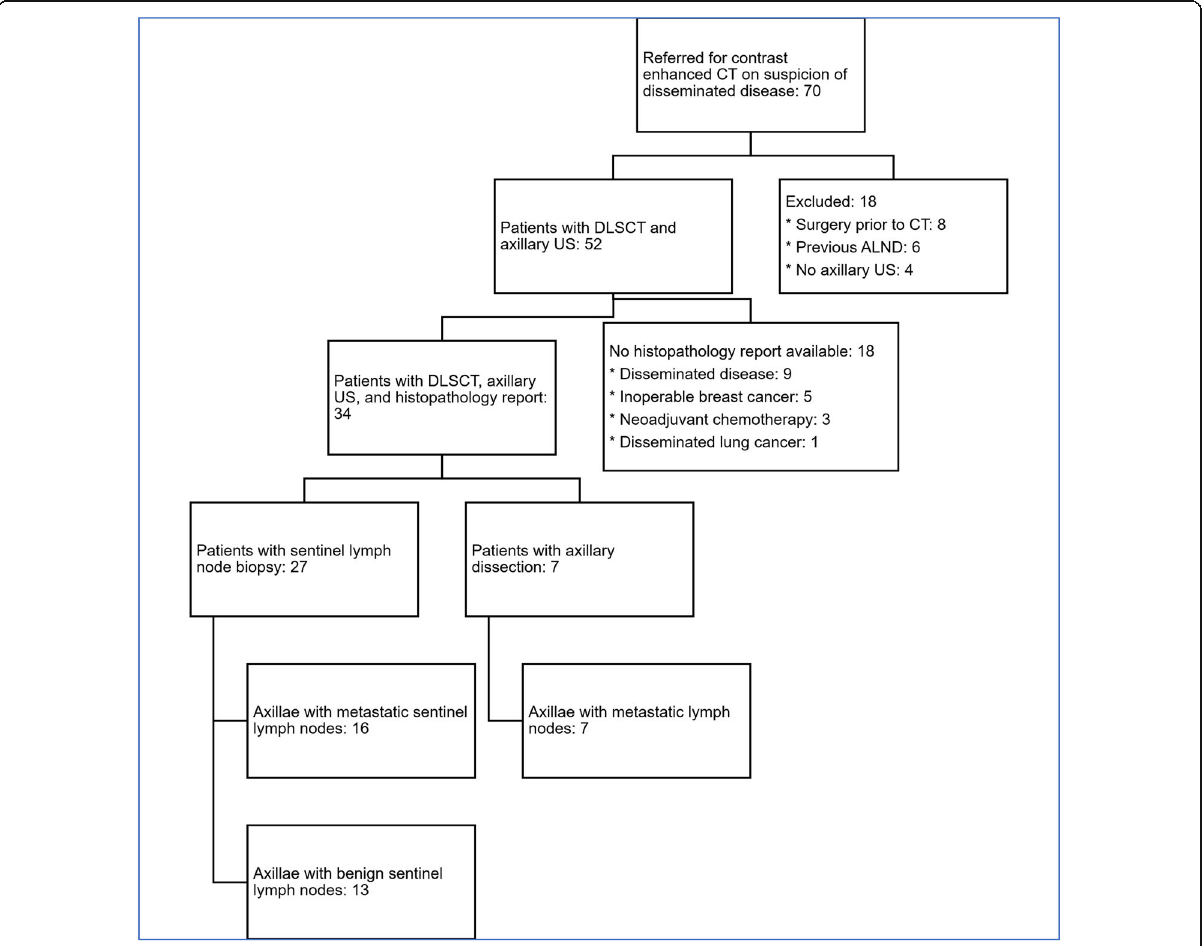
Fig. 2 Flowchart showing the patient enrolment. A total of 29 sentinel lymph node biopsies were performed in 27 patients since two patients had bilateral breast cancer. ALND Axillary lymph node dissection, DLSCT Dual-layer spectral CT, US